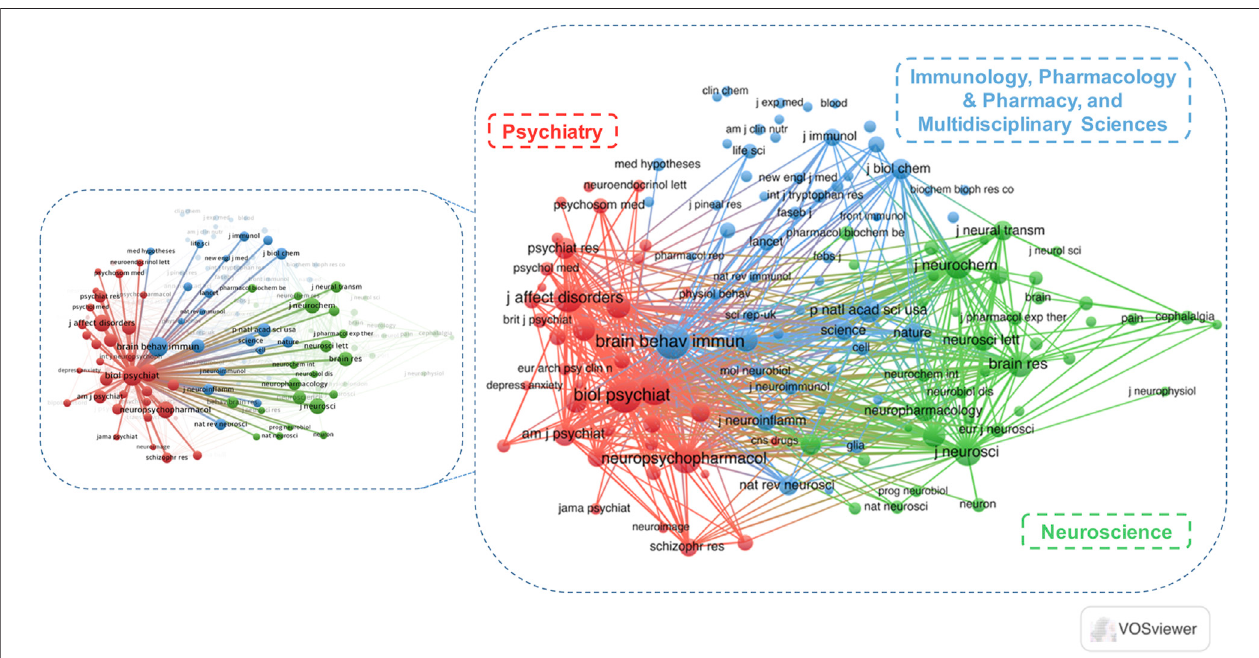
FIGURE 7 | Cluster visualization of the journal co-citation analysis. Each node represents a journal, and the size of each circle is determined by the co-citations of the journal.